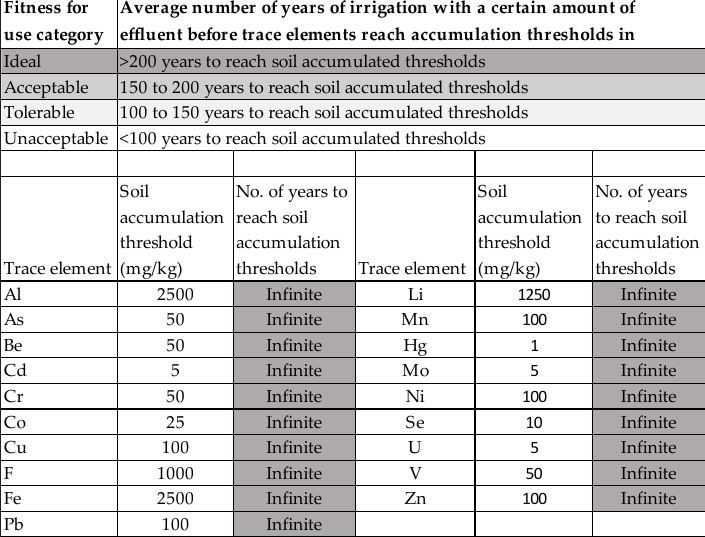
Figure 6. Effects of AF effluent irrigation on the accumulation of trace elements.